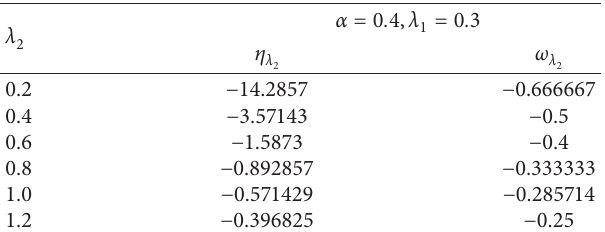
Table 7: Sensitivity and relativity sensitivity analysis of MTTF